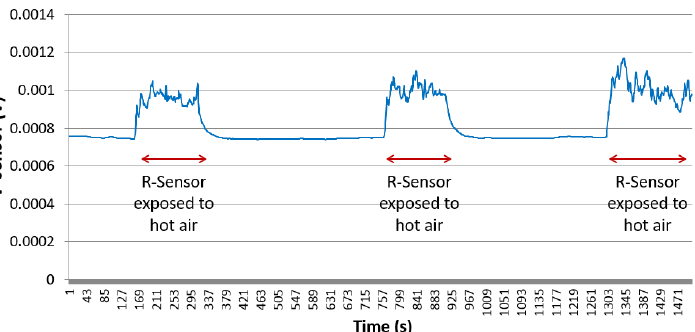
Figure 14. Sensor output voltage over time, as function of air temperature surrounding the sensing